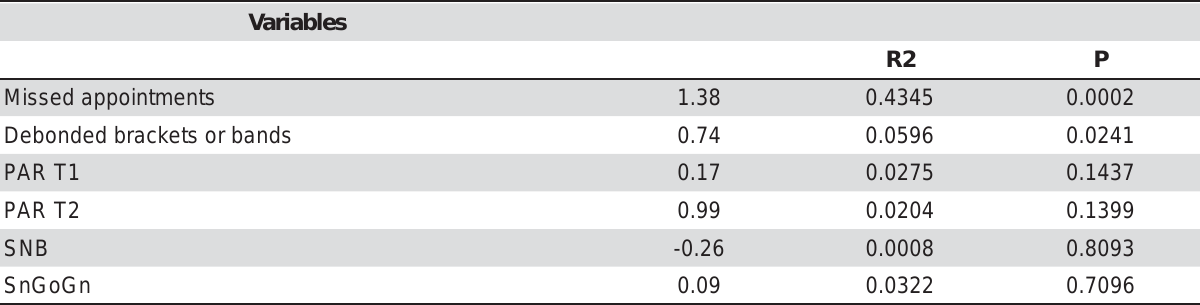
Table 2- (cid:48)(cid:88)(cid:79)(cid:87)(cid:76)(cid:83)(cid:79)(cid:72)(cid:3)(cid:79)(cid:76)(cid:81)(cid:72)(cid:68)(cid:85)(cid:3)(cid:85)(cid:72)(cid:74)(cid:85)(cid:72)(cid:86)(cid:86)(cid:76)(cid:82)(cid:81)(cid:3)(cid:68)(cid:81)(cid:71)(cid:3)(cid:86)(cid:87)(cid:72)(cid:83)(cid:90)(cid:76)(cid:86)(cid:72)(cid:3)(cid:86)(cid:87)(cid:68)(cid:87)(cid:76)(cid:86)(cid:87)(cid:76)(cid:70)(cid:86)(cid:3)(cid:82)(cid:73)(cid:3)(cid:76)(cid:81)(cid:71)(cid:72)(cid:83)(cid:72)(cid:81)(cid:71)(cid:72)(cid:81)(cid:87)(cid:3)(cid:89)(cid:68)(cid:85)(cid:76)(cid:68)(cid:69)(cid:79)(cid:72)(cid:86)(cid:3)(cid:86)(cid:75)(cid:82)(cid:90)(cid:76)(cid:81)(cid:74)(cid:3)(cid:86)(cid:76)(cid:74)(cid:81)(cid:76)(cid:191)(cid:70)(cid:68)(cid:81)(cid:87)(cid:3)(cid:70)(cid:82)(cid:85)(cid:85)(cid:72)(cid:79)(cid:68)(cid:87)(cid:76)(cid:82)(cid:81)(cid:3)(cid:90)(cid:76)(cid:87)(cid:75)(cid:3) class III treatment duration (F=9.99,